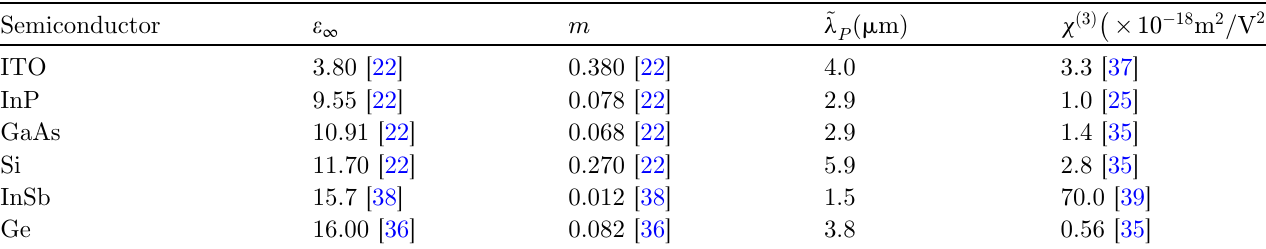
Table 1. The materials studied and their properties. Semiconductor